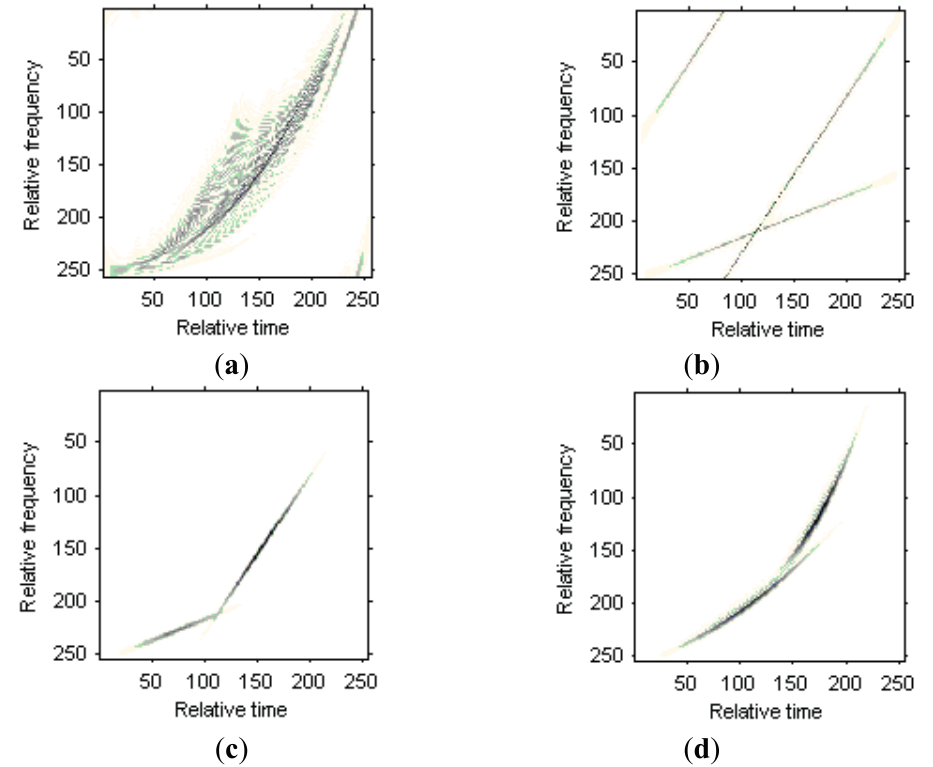
Figure 7. Time frequency representations for the received signal in a range bin. ( a ) WVD for the original signal; ( b ) WVD for two LFM signal components; ( c ) WVD for two Chirplet components; ( d ) WVD for two modified version of Chirplet